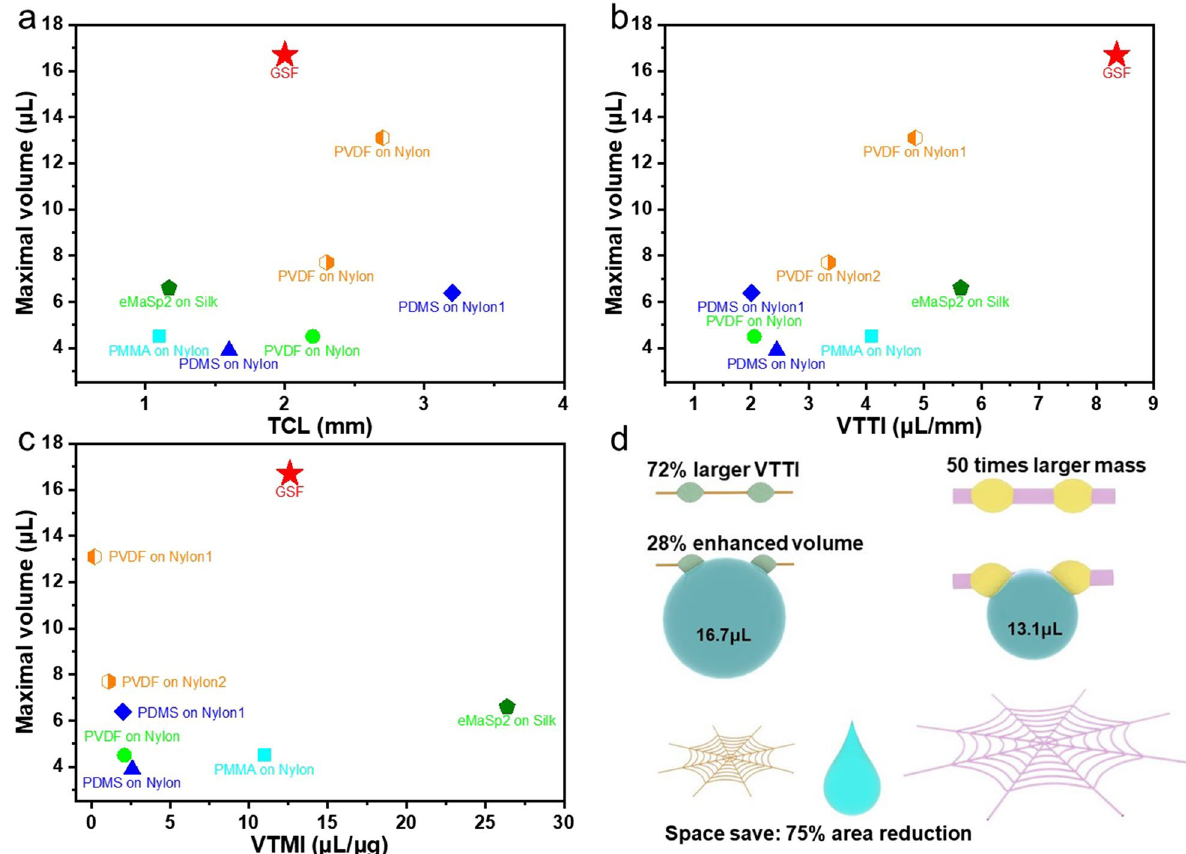
Fig. 7 Comparison of fog collection performance. a Maximal volume of droplets collected by different SCS mimicing fibers with various TCLs. b Maximal volume versus volume-to-TCL index (VTTI) for GSF10 and previous reported fibers. c Maximal volume versus volume-to-mass index (VTMI) for GSF10 and previous reported fibers [23]. d Schematic picture showing comparison of water collection performance between GSF10 and the best existing polymer fiber regarding the efficiency, VTTI and